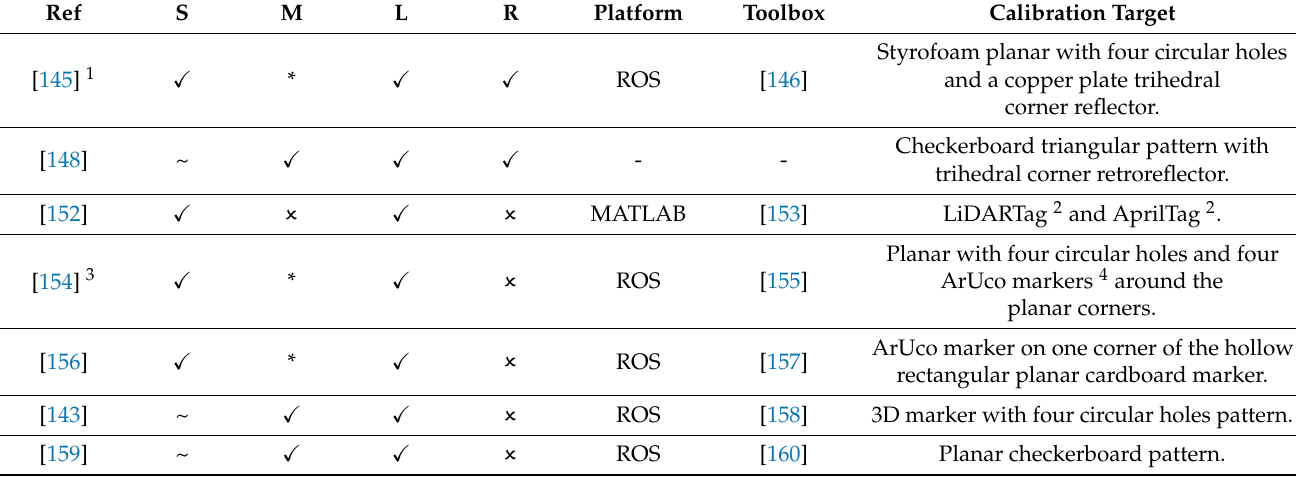
with modification. Table 5. An overview of the available open-source extrinsic sensor calibration tools for multi-sensing modalities, specifically for LiDAR, radar, stereo camera, and monocular camera. The acronyms of the columns (from left to right) are the referenced literature (Ref), stereo camera (S), monocular camera (M), LiDAR (L) and Radar (R). The platform and toolbox column Table 5. An overview of the available open-source extrinsic sensor calibration tools for multi-sensing modalities, specifi- Table 5. An overview of the available open-source extrinsic sensor calibration tools for multi-sensing modalities, specifi- refer to the working environment of the toolbox and a reference link to the open-source calibration toolbox. Further, the cally for LiDAR, radar, stereo camera, and monocular camera. The acronyms of the columns (from left to right) are the cally for LiDAR, radar, stereo camera, and monocular camera. The acronyms of the columns (from left to right) are the referenced literature (Ref), stereo camera (S), monocular camera (M), LiDAR (L) and Radar (R). The platform and toolbox referenced literature (Ref), stereo camera (S), monocular camera (M), LiDAR (L) and Radar (R). The platform and toolbox Table 5. An overview of the available open-source extrinsic sensor calibration tools for multi-sensing modalities, specifi- column refer to the working environment of the toolbox and a reference link to the open-source calibration toolbox. Fur- cally for LiDAR, radar, stereo camera, and monocular camera. The acronyms of the columns (from left to right) are the ther, the calibration target column summarizes the calibration target used for extrinsic sensor calibration. The symbols  referenced literature (Ref), stereo camera (S), monocular camera (M), LiDAR (L) and Radar (R). The platform and toolbox and  indicate whether the proposed open-source toolbox can calibrate a particular sensor. The “ * ” symbol indicates that Table 5. An overview of the available open-source extrinsic sensor calibration tools for multi-sensing modalities, specifi- the proposed calibration tool claims to support monocular camera calibration. The “ ~ ” symbol indicates that a stereo cam- cally for LiDAR, radar, stereo camera, and monocular camera. The acronyms of the columns (from left to right) are the Table 5. An overview of the available open-source extrinsic sensor calibration tools for multi-sensing modalities, specifi- era could be calibrated as two separate monocular cameras, but in principle, it is suboptimal. The “ - “ symbol indicates referenced literature (Ref), stereo camera (S), monocular camera (M), LiDAR (L) and Radar (R). The platform and toolbox cally for LiDAR, radar, stereo camera, and monocular camera. The acronyms of the columns (from left to right) are the that the extrinsic calibration tool is not mentioned or openly or freely available to the research community. Based on [145] column refer to the working environment of the toolbox and a reference link to the open-source calibration toolbox. Fur- Table 5. An overview of the available open-source extrinsic sensor calibration tools for multi-sensing modalities, specifi- referenced literature (Ref), stereo camera (S), monocular camera (M), LiDAR (L) and Radar (R). The platform and toolbox with modification. ther, the calibration target column summarizes the calibration target used for extrinsic sensor calibration. The symbols  cally for LiDAR, radar, stereo camera, and monocular camera. The acronyms of the columns (from left to right) are the column refer to the working environment of the toolbox and a reference link to the open-source calibration toolbox. Fur- and  indicate whether the proposed open-source toolbox can calibrate a particular sensor. The “ * ” symbol indicates that referenced literature (Ref), stereo camera (S), monocular camera (M), LiDAR (L) and Radar (R). The platform and toolbox ther, the calibration target column summarizes the calibration target used for extrinsic sensor calibration. The symbols  the proposed calibration tool claims to support monocular camera calibration. The “ ~ ” symbol indicates that a stereo cam- column refer to the working environment of the toolbox and a reference link to the open-source calibration toolbox. Fur- Styrofoam planar with four circular holes and a copper plate Styrofoam planar with four circular holes and a copper plate and  indicate whether the proposed open-source toolbox can calibrate a particular sensor. The “ * ” symbol indicates that era could be calibrated as two separate monocular cameras, but in principle, it is suboptimal. The “ - “ symbol indicates corner reflector. [146] ther, the calibration target column summarizes the calibration target used for extrinsic sensor calibration. The symbols  trihedral corner reflector. trihedral corner reflector. the proposed calibration tool claims to support monocular camera calibration. The “ ~ ” symbol indicates that a stereo cam- that the extrinsic calibration tool is not mentioned or openly or freely available to the research community. Based on [145] and  indicate whether the proposed open-source toolbox can calibrate a particular sensor. The “ * ” symbol indicates that Checkerboard triangular pattern with Checkerboard triangular pattern with trihedral corner retrore- Checkerboard triangular pattern with trihedral corner retrore- era could be calibrated as two separate monocular cameras, but in principle, it is suboptimal. The “ - “ symbol indicates Styrofoam planar with four circular holes and a copper plate with modification. the proposed calibration tool claims to support monocular camera calibration. The “ ~ ” symbol indicates that a stereo cam- - - trihedral corner retroreflector. [146] flector. flector. that the extrinsic calibration tool is not mentioned or openly or freely available to the research community. Based on [145] trihedral corner reflector. era could be calibrated as two separate monocular cameras, but in principle, it is suboptimal. The “ - “ symbol indicates with modification. LiDARTag 2 and AprilTag 2 . Checkerboard triangular pattern with trihedral corner retrore- that the extrinsic calibration tool is not mentioned or openly or freely available to the research community. Based on [145] - Styrofoam planar with four circular holes and a copper plate Planar with four circular holes and four ArUco markers 4 flector. Planar with four circular holes and four with ROS [146] Platform Toolbox Calibration Target [155] trihedral corner reflector. around the planar corners. ROS [155] ArUco markers 4 around the Styrofoam planar with four circular holes and a copper plate Checkerboard triangular pattern with trihedral corner retrore- planar corners. ROS [146] ArUco marker on one corner of the hollow rectangular planar Planar with four circular holes and four ArUco markers 4 - trihedral corner reflector. [157] flector. cardboard marker. around the planar corners. ArUco marker on one corner of the hollow Checkerboard triangular pattern with trihedral corner retrore- ROS [157] MATLAB [153] LiDARTag 2 and AprilTag 2 . - 3D marker with four circular holes pattern. rectangular planar cardboard marker. ArUco marker on one corner of the hollow rectangular planar flector. Planar with four circular holes and four ArUco markers 4 [160] Planar checkerboard pattern. cardboard marker. [155] MATLAB LiDARTag 2 and AprilTag 2 . around the planar corners. Planar with four circular holes and four ArUco markers 4 ArUco marker on one corner of the hollow rectangular planar [155] Planar checkerboard pattern. [157] around the planar corners. cardboard marker. 1 The toolbox binds with the commonly employed ROS and includes a monocular camera detector for extrinsic calibration, [158] 3D marker with four circular holes pattern. but reported results relate to stereo camera only [145]. 2 LiDARTag (point clouds) and AprilTag (images) is a visual fiducial [160] Planar checkerboard pattern. tag (QR-code like pattern). 3 The extrinsic calibration tool is an enhancement version of the previous work from [161]. 4 1 The toolbox binds with the commonly employed ROS and includes a monocular camera detector for extrinsic calibration, ArUco marker is a synthetic 2D square marker with a wide black border and an inner binary matrix. but reported results relate to stereo camera only [145]. 2 LiDARTag (point clouds) and AprilTag (images) is a visual fiducial tag (QR-code like pattern). 3 The extrinsic calibration tool is an enhancement version of the previous work from [161]. 4 ArUco marker is a synthetic 2D square marker with a wide black border and an inner binary matrix.